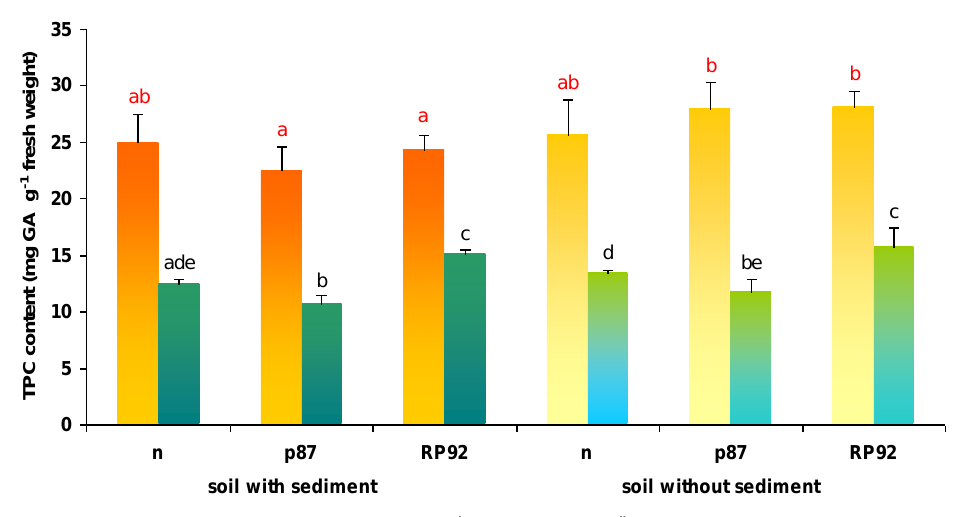
Figure 8. Total phenolic content (TPC) content in leaves of T. patula and F. arundinacea grown on control and bottom sediment-amended soil with or without (n) inoculation with bacterial strain p87 or RP92. The same letters denote groups that did not significantly differ (at p < 0.05; the Duncan post hoc test). Statistical significance was measured for each plant separately and the results were marked by different colors.